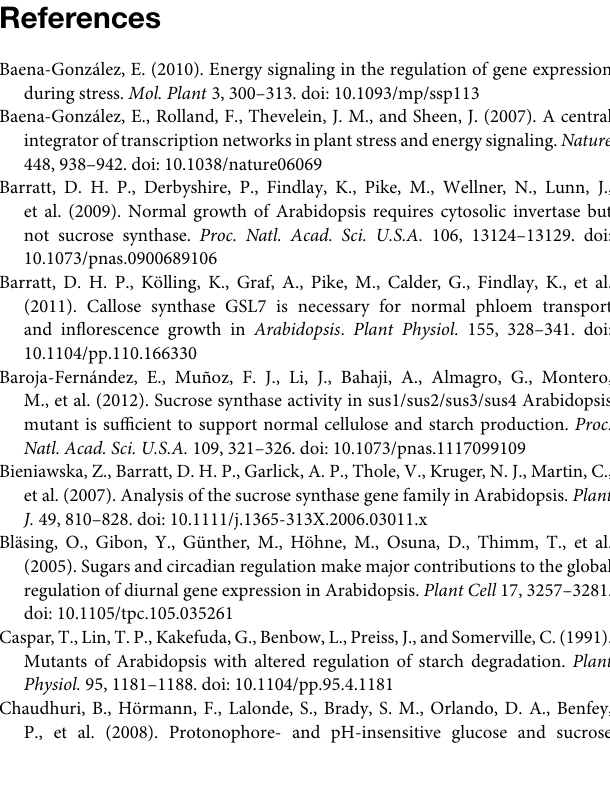
Figure S2 | Effects of sugars added to the agar growth medium on expression of bZIP63 in the pbZIP63::GUS line. A. thaliana seedlings were germinated and grown (under a 16h light/8h dark photoperiod) for 7 days on solid 0.5 × MS agar media containing either no sugar, or Glc (0.3 or 3%) or Suc (0.3 or 3%), and the expression of bZIP63 was visualized by GUS staining. Figure S3 | A relationship between internal Glc and Suc content and expression of selected genes in liquid-media-grown Arabidopsis wt plants and HXK1-transgenics ( gin2.1 mutant and oe3.2 overexpressor) exposed to external sugar. The plots were generated based on data from Figures 1 , 2 , 5 , 6 . Data points indicated by gray circles and spots represent “standard samples” and “standard curves,” respectively, and show the correlation between the averaged sugar and gene expression data from plants grown on solid media under steady state condition. The underlying data are derived from Figures 1 , 2 . Data points indicated by black, red and blue marks show the relation between sugar content and gene expression in wt and HXK1-transgenics. The underlying data are derived from Figures 5 , 6 . Please note that, for genes down-regulated by sugars (A–D) , the expression was clearly responsive to both Glc and Suc; however, it was only Glc, but not Suc, which at high concentration elicited an enhanced response in oe3.2 overexpressor (when compared to its Be-0 wt control). For MGD2 (E) , the expression was less sensitive to sugar content, with the exception of oe3.2 plants where effects of both Glc and Suc were enhanced. Please note also that, at high sugar concentration, the data for TPS9 and MGD2 are considerably shifted from their respective “standard curves.” Supplementary Table1 | List of qPCR